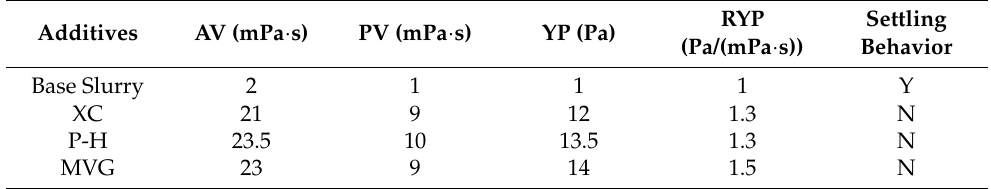
Table 3. Rheology and stability of the slurries after adding the examined natural polymers.